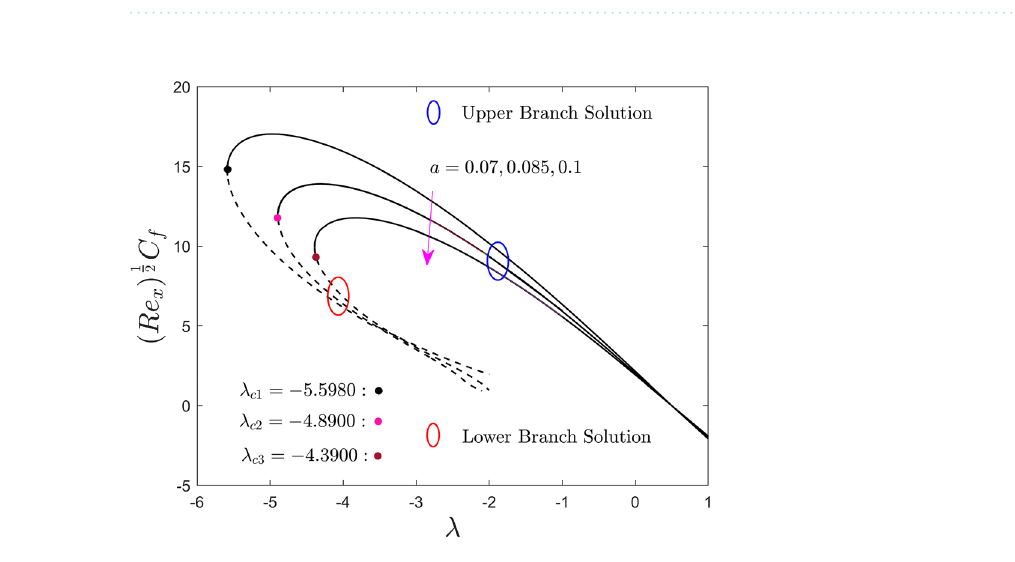
Figure 5. Effect of needle size a on the skin friction coefficient ( Re x )